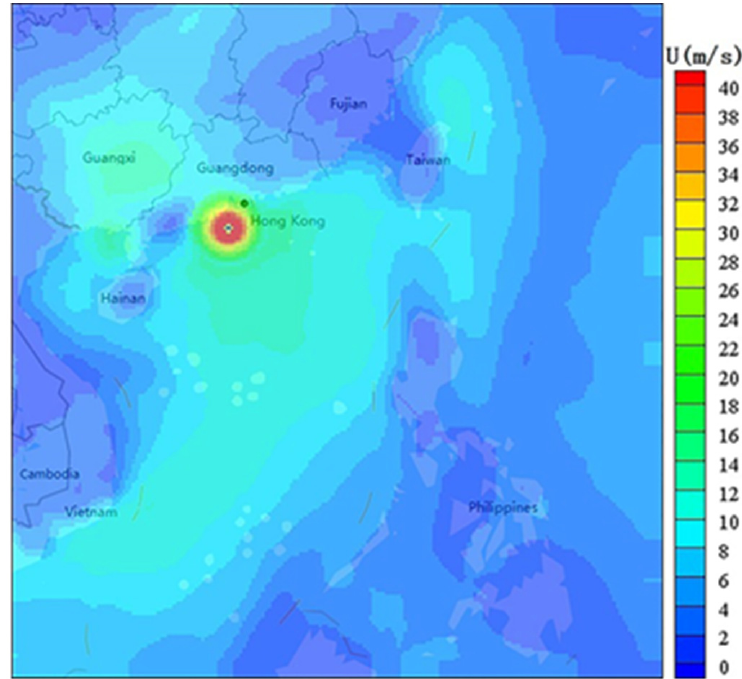
Figure 5. Cloud map of the synthetic wind field of Typhoon Mangkut.